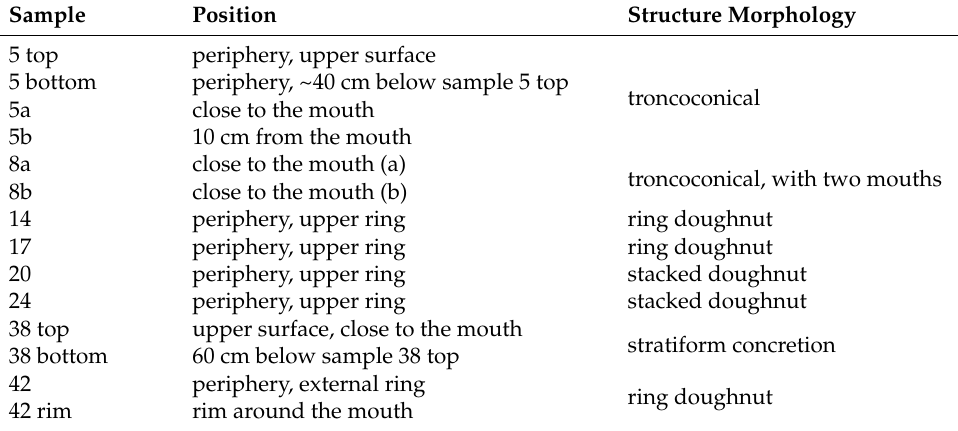
Table 2. Position of sampling points from selected structures and